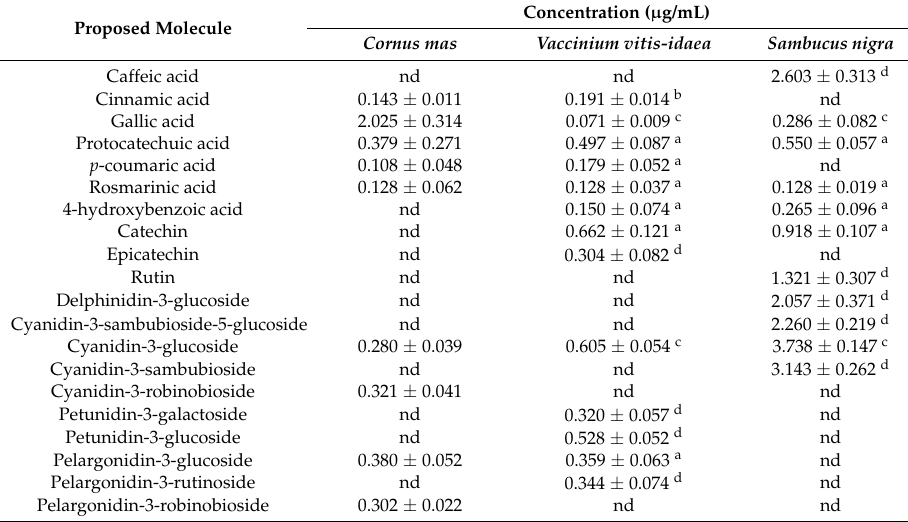
Table 2. Phenolic profiles of investigated berry juices.